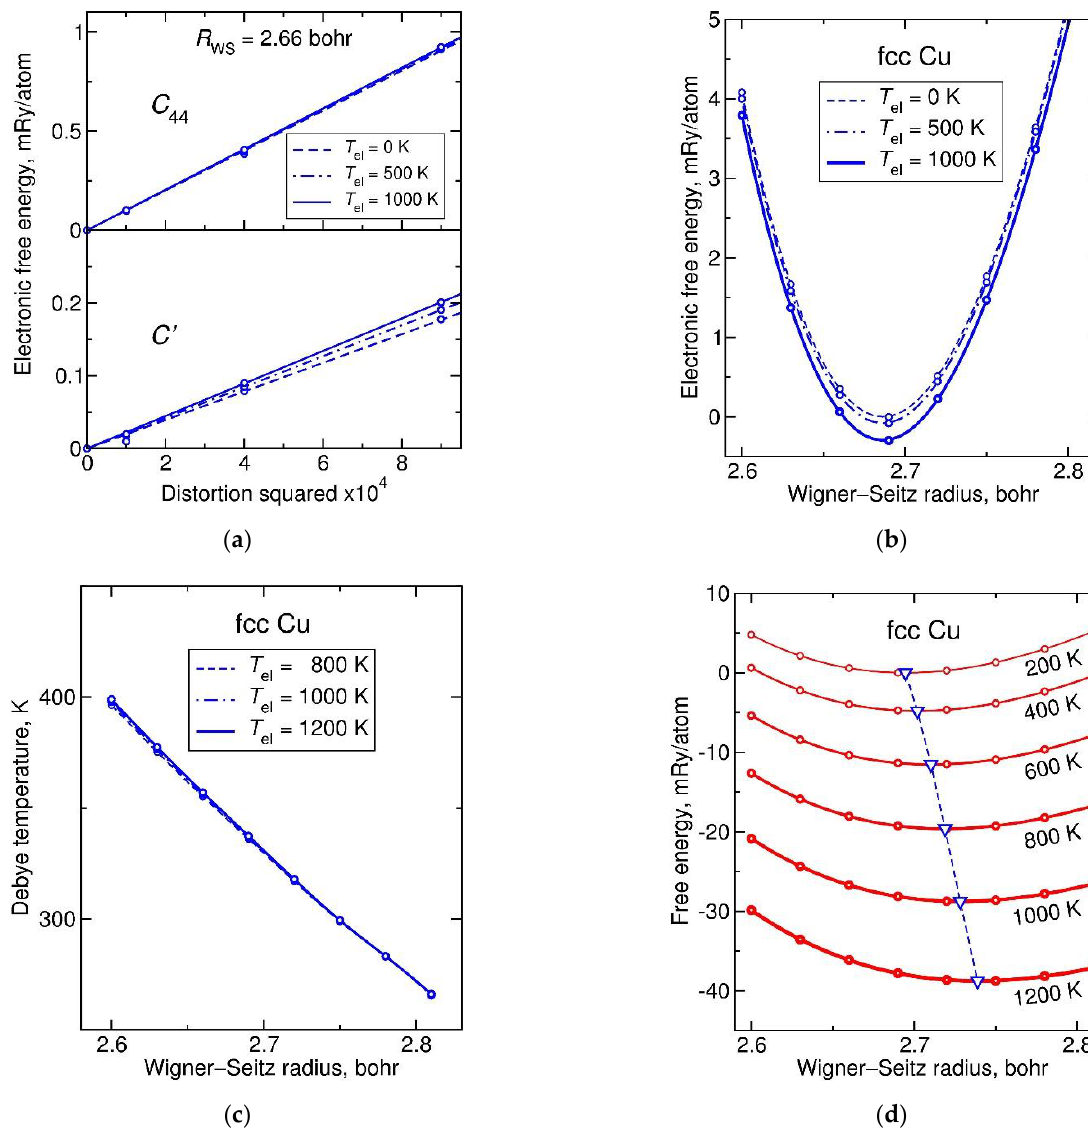
Figure 1. Parameterization of the Debye model using elastic property calculations for fcc Cu, a metal with a closed d - electron shell: ( a ) electronic free energy dependencies on two volume-conserving distortions, to calculate shear elastic moduli 𝐶 44 and 𝐶′ at each considered Wigner–Seitz radius 𝑅 WS and electronic temperature 𝑇 el ; ( b ) electronic free energy dependence upon isotropic strain, to calculate adiabatic bulk modulus 𝐵 el (𝑉 , 𝑇 el ) ; ( c ) Debye temperature estimated from 𝐶 44 , 𝐶′ , and 𝐵 el ; ( d ) Helmholtz free energy obtained by adding the vibrational free energy in the Debye model to the electronic free energy. Dashed line with down triangles indicates the temperature-dependent equilibrium volume.